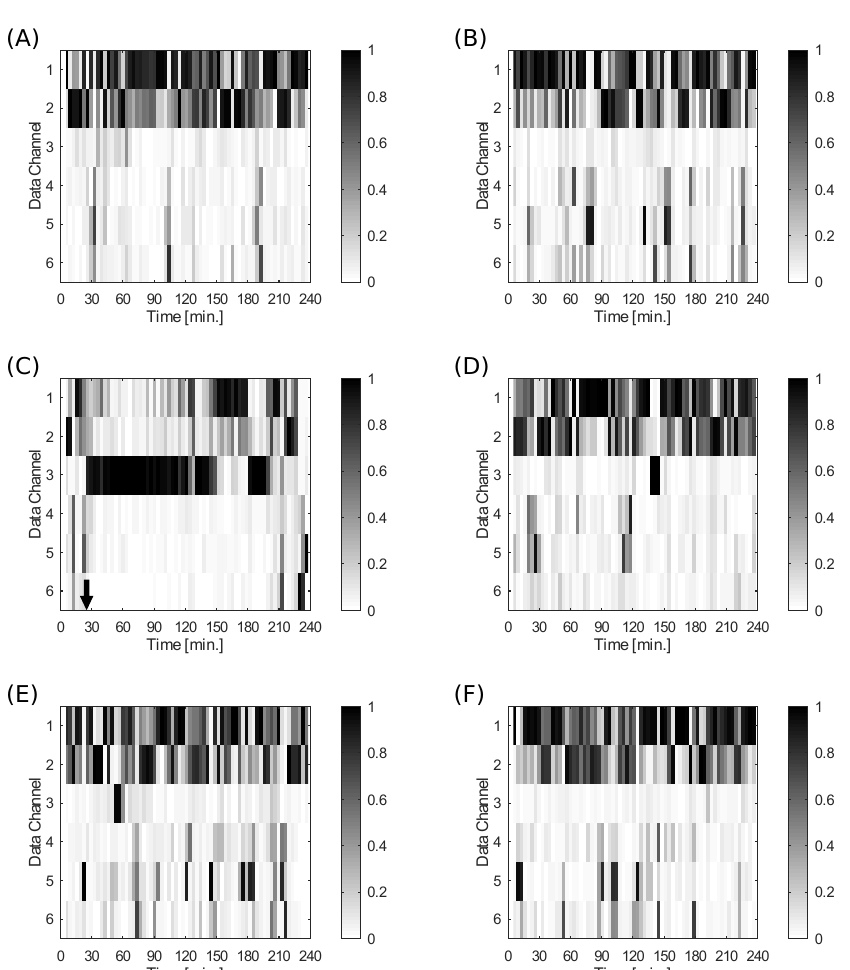
Figure 8. Transition of the eigenstate around the Kumamoto earthquake for ( A ) 2016/106/8-12, ( B ) 2016/106/12-16, ( C ) 2016/106/16-20, ( D ) 2016/106/20-24, ( E ) 2016/107/0-4, ( F ) 2016/107/4-8.